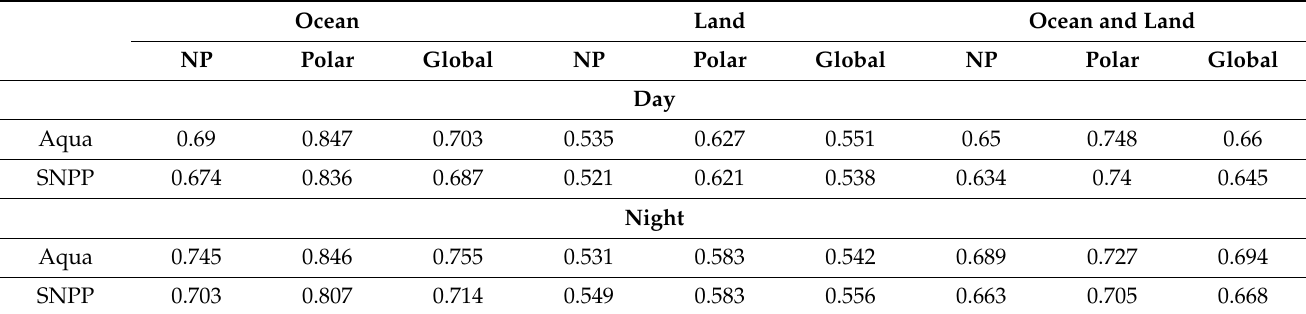
Table 2. Mean cloud amounts from Aqua Ed4 and SNPP Ed1a for 2012–2020. Ocean Land Ocean and Land